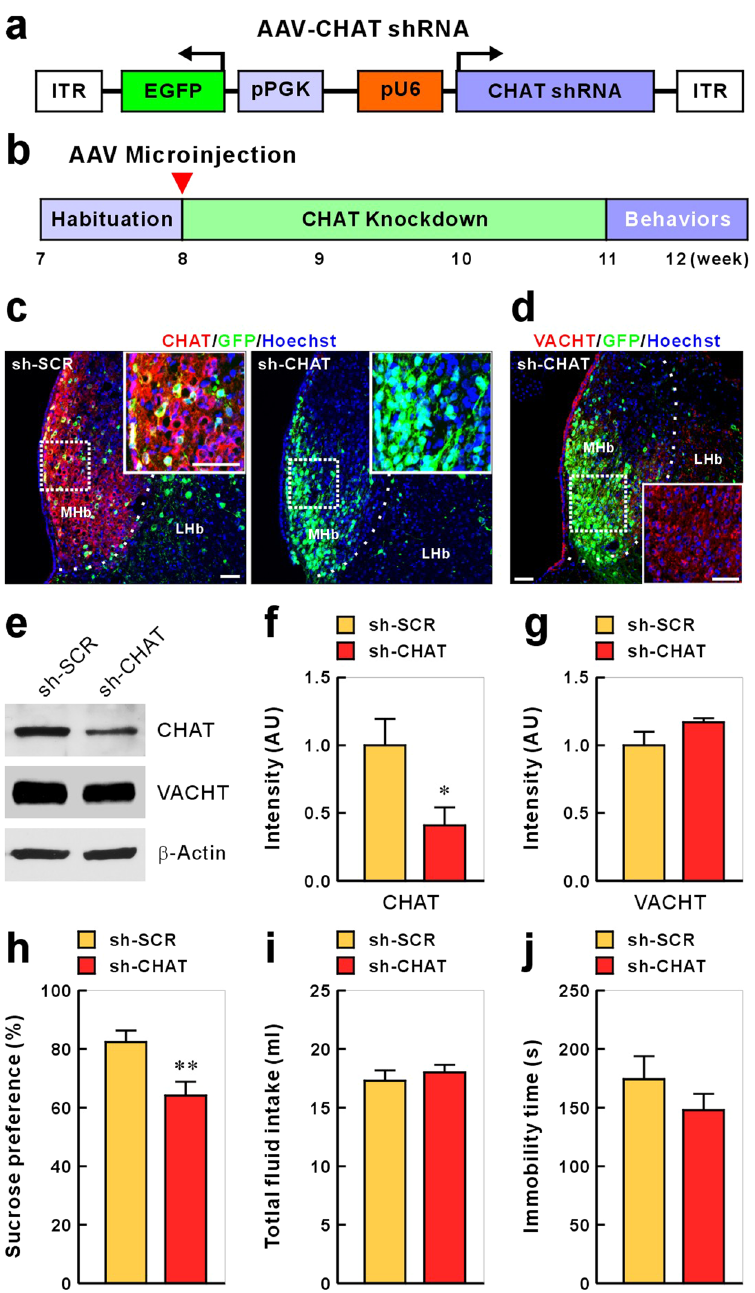
Figure 2. Effects of CHAT knockdown in medial habenula on depression-like behaviors. ( a ) Schematic representation of the AAV vector engineered to induce CHAT knockdown. ( b ) Experimental paradigm for behavioral testing of rats infected with the virus. ( c ) Representative photomicrographs of Hb slices from the rats injected with AAV-sh-SCR (control) or AAV-sh-CHAT (CHAT knockdown). CHAT protein expression was visualized as red immunofluorescence. Cell nuclei and viral infection were visualized using Hoechst staining (blue) and GFP (green), respectively. The inset box shows a higher magnification of an infected MHb region. None of the neurons infected with the AAV-sh-CHAT showed CHAT expression. Scale bar, 50 μ m. ( d ) VACHT expression is not affected by AAV-sh-CHAT. Hb neurons injected with AAV-sh-CHAT were immunostained for VACHT (red) and EGFP (green). Scale bar, 50 μ m. ( e ) CHAT and VACHT western blots from the Hb of rats injected with AAV-sh-CHAT. Rats were injected with AAV-sh-SCR (control) or AAV-sh-CHAT, which were expressed for 3 weeks before western blot analysis. ( f ) Quantification of the effects of shRNA-mediated CHAT knockdown. Data represent mean ± SEM (sh-SCR, n = 4 rats; sh-CHAT, n = 4; * P < 0.05, Student’s t -test). ( g ) VACHT expression is not affected by AAV-sh-CHAT. Data represent mean ± SEM (sh-SCR, n = 4 rats; sh- CHAT, n = 4) ( h – j ) Behavioral effects of expressing AAV-sh-CHAT in the MHb on sucrose preference ( h ), total fluid intake during SPT test ( i ), and forced swim ( j ). Data represent mean ± SEM (sh-SCR, n = 20; sh-CHAT, n = 27; ** P < 0.01, Student t